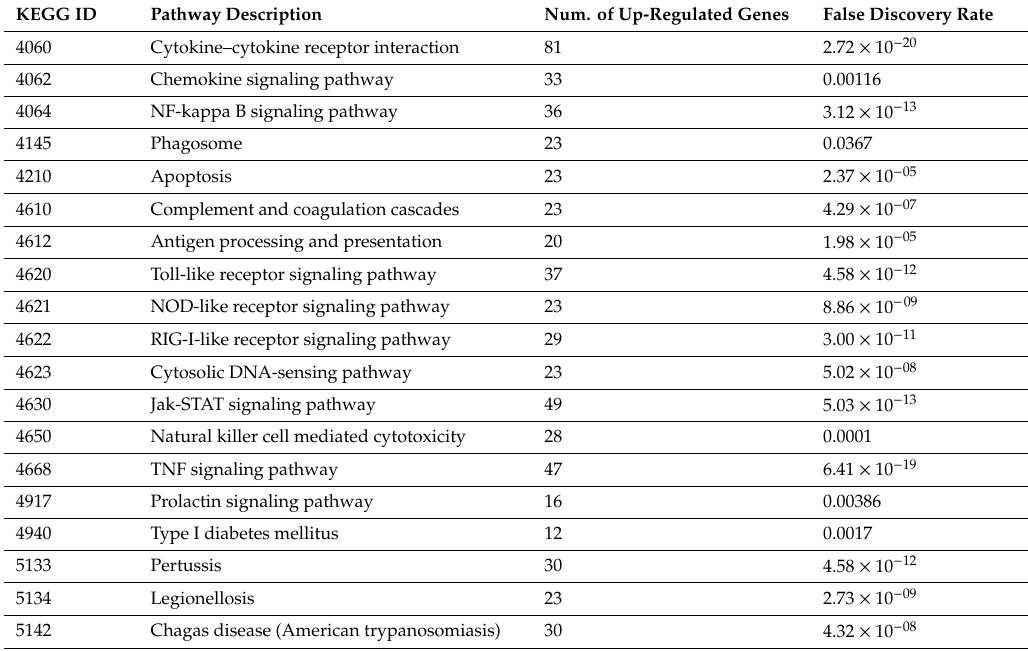
Table 1. Common KEGG pathways enriched in up-regulated gene sets of 6, 12, and 24 hpi. KEGG ID Pathway